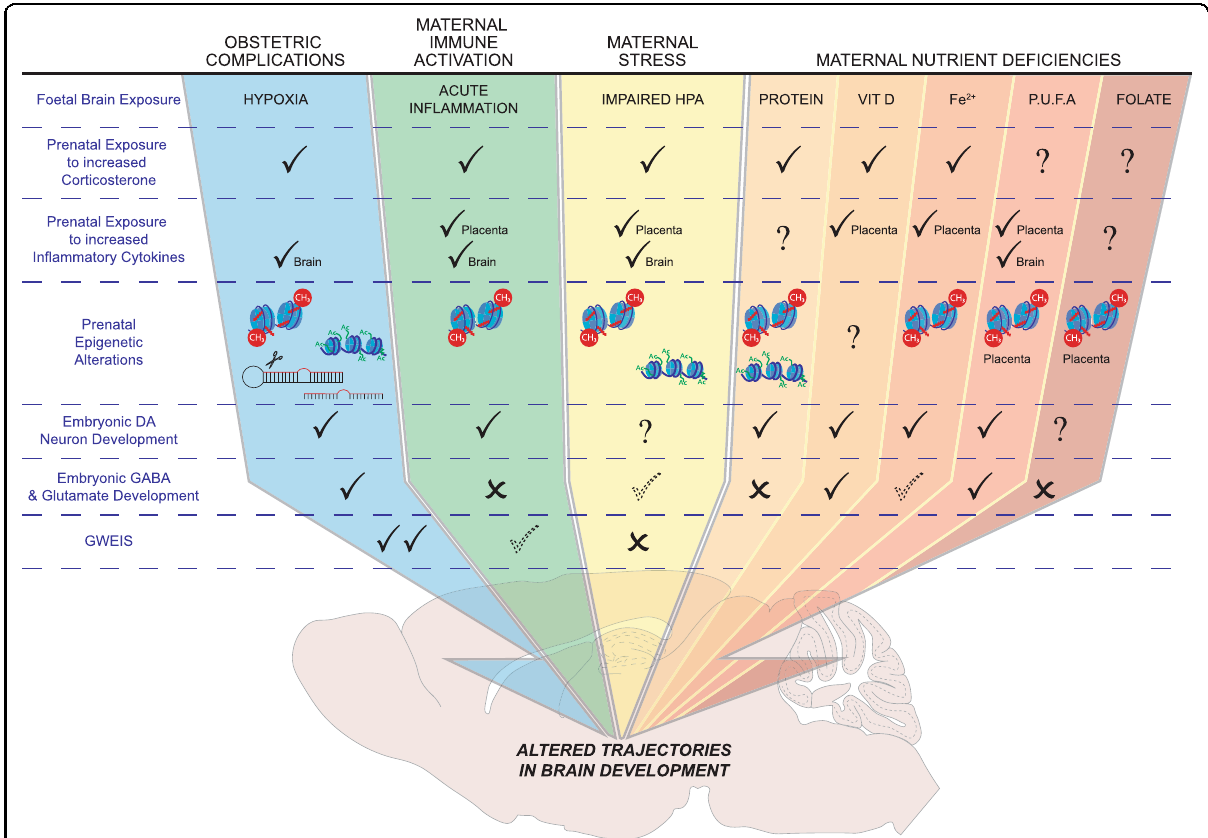
Fig. 2 Epidemiologically-validated developmental risk factors for schizophrenia and the convergent processes affecting brain development. This fi gure depicts the multiple convergent processes operating across the prominent developmental risk factors for schizophrenia. Almost all exposures increase foetal brain/placental exposure to increased glucocorticoids and in fl ammatory factors. There are also multiple alterations to early epigenetic factors governing gene expression, with most risk exposures affecting DNA methylation, however certain exposures also affect histone acetylation/methylation and micro RNA production. At a cellular level a surprisingly high number of exposures affect the early ontogeny of dopamine neurons. Effects on the development of other brain cell types i.e. GABA or glutamateric are also affected but reports of alterations to these neurons are far less frequent. Also noted is whether genome-wide environmental interaction (GWEIS) studies have been conducted for these developmental risk exposures. Abbreviations: DA, dopamine; GWEIS, genome wide environment interaction study; HPA, hypo-thalamic pituitary axis; Vit D, vitamin D; Fe 2 + , iron; PUFA, polyunsaturated fatty acids. Increased exposure validated in developing brain/